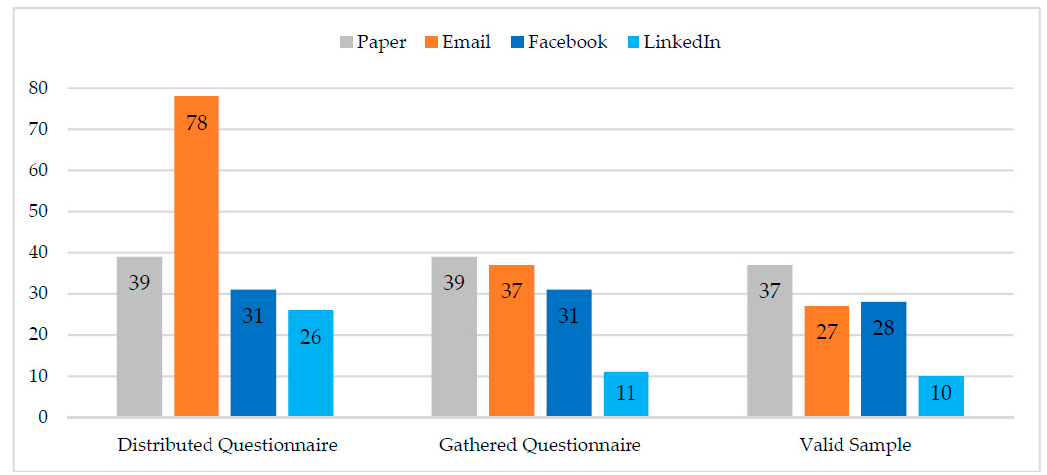
Figure 3. The number of distributed, gathered, and valid questionnaires by the survey methods.